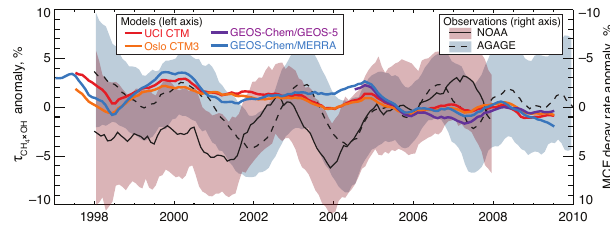
Fig. 2. Interannual variability of τ CH in CTMs and observed 4 × OH global-mean methyl chloroform (MCF) decay rate. Observations are derived from atmospheric MCF abundances at NOAA and AGAGE surface stations (Montzka et al., 2000; Prinn et al., 2005), with an uncertainty (shaded) given by the 16th to 84th percentile range ( ± 1 σ ) of decay rates across stations within each network, and adjusted by the tropospheric OH fraction of total MCF loss. All data are shown as anomalies relative to their own 2004–2010 mean (2004–2008 for NOAA data). Models, observations, and uncertain- ties are smoothed with a 12-month running average. Note anomalies in τ CH and decay rate have opposite 4 × OH